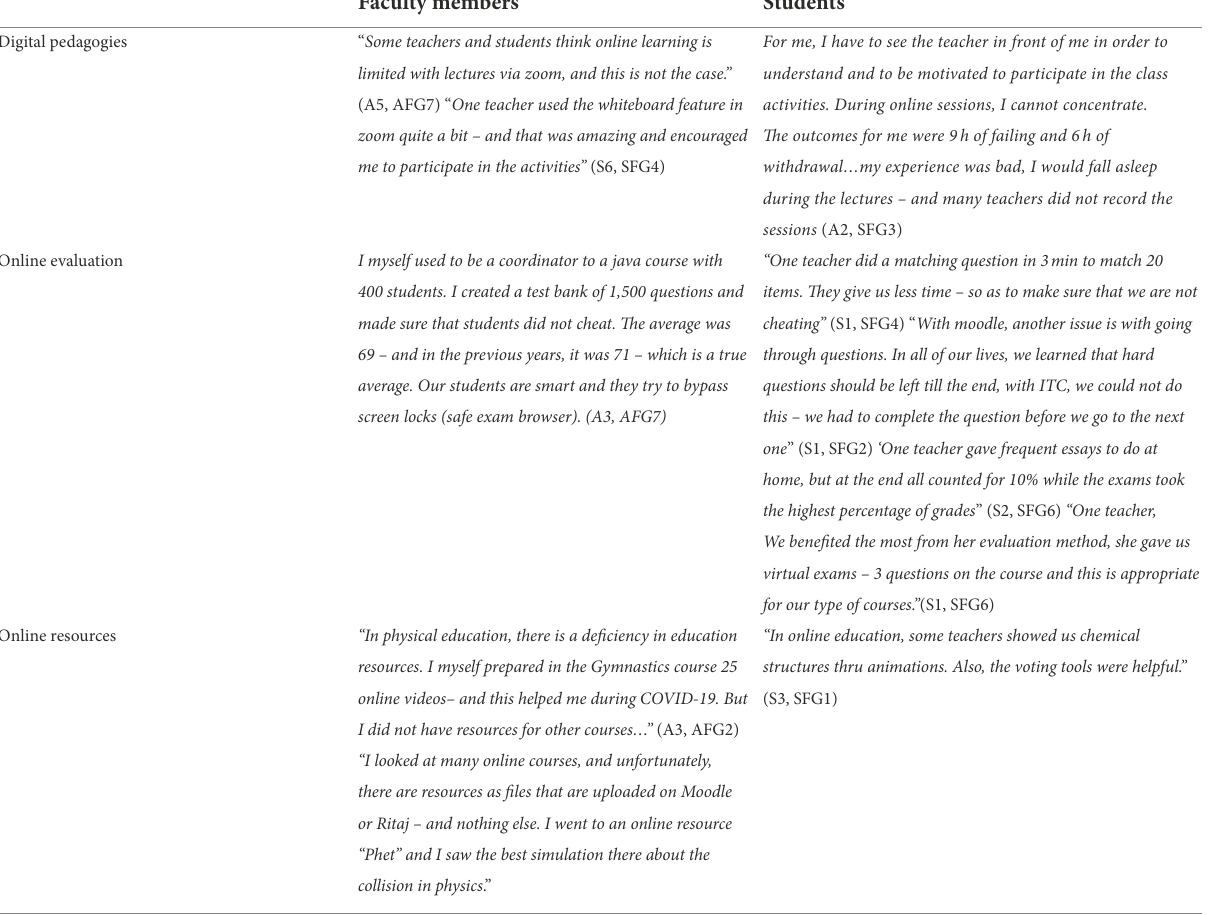
TABLE 8 Digital pedagogy and online